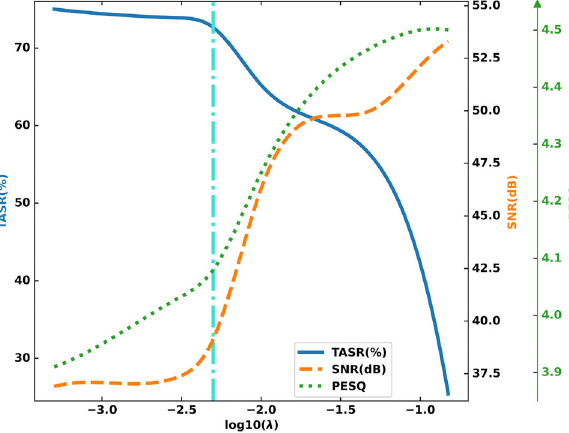
Fig. 5 Parametersensitivitywithrespectto λ onCSIwith x-vector asthe speaker recognition model. The vertical line indicates the performance with λ (cid:2) 0.005. d and ζ are fixed to L/ 3 and 0.003, respectively